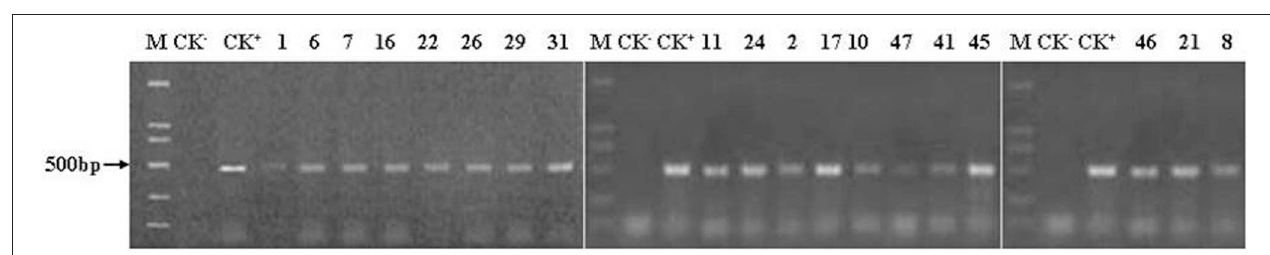
FIGURE 3 | PCR amplification of the npt II gene. M, DL marker 2 000; CK − m negative control (non-transgenic poplar); CK + , positive control (plasmid pBtiA); the others are the 6-year-old transgenic lines. 19 transgenic lines and the positive control were all detected the expected bands (500 bp), while the negative control was not detected.